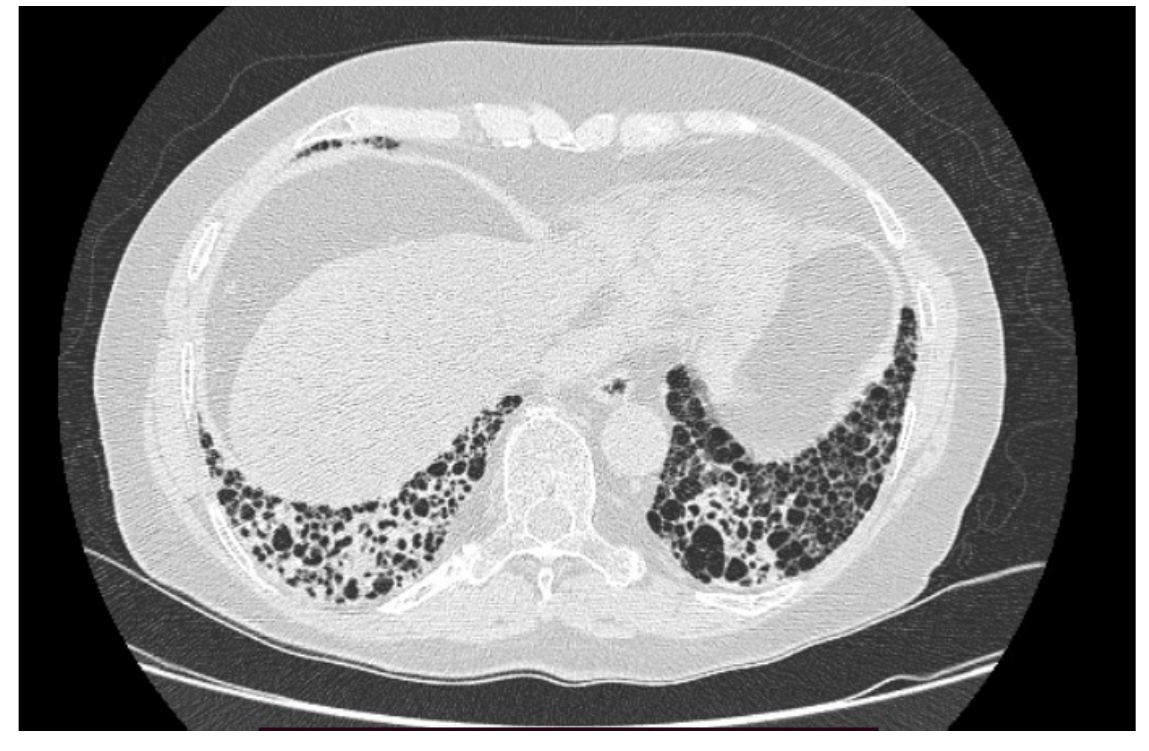
Figure 1. UIP in course of IPF.